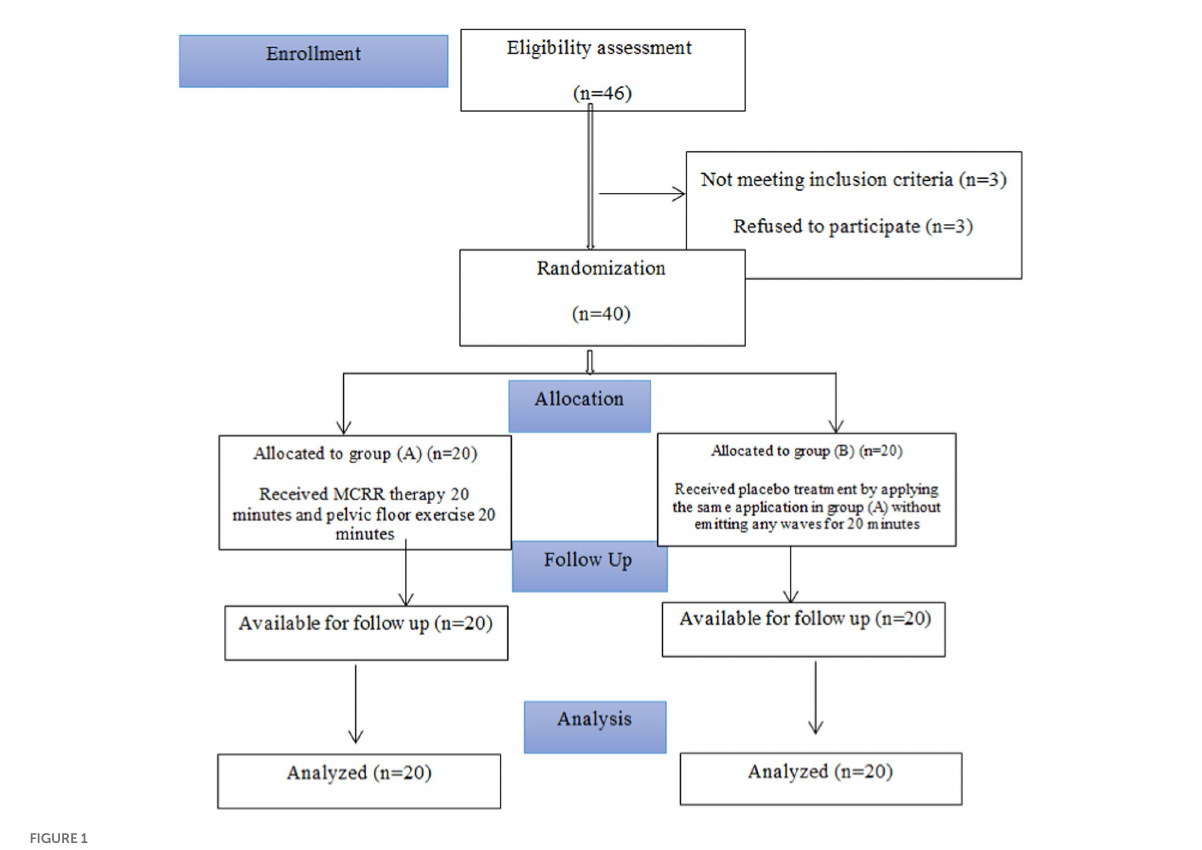
FIGURE 1 Flow chart of